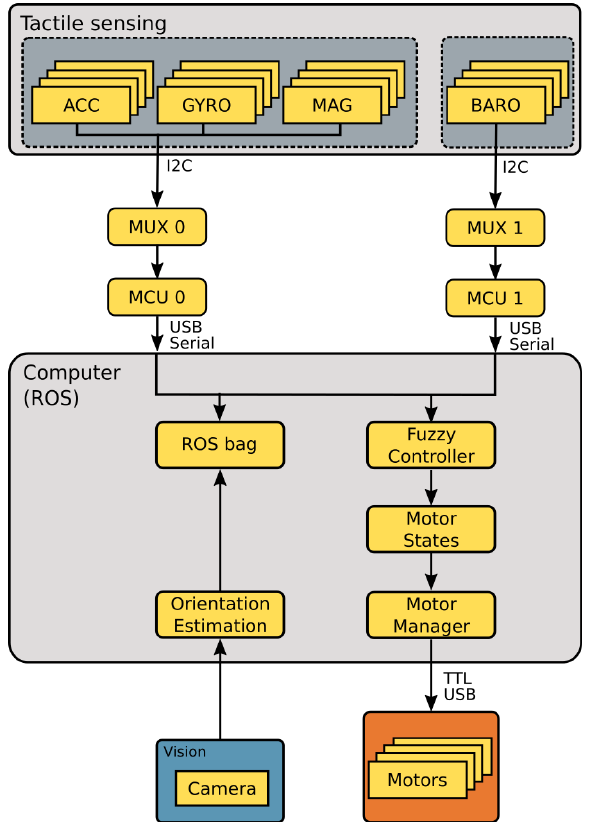
Figure 3. System